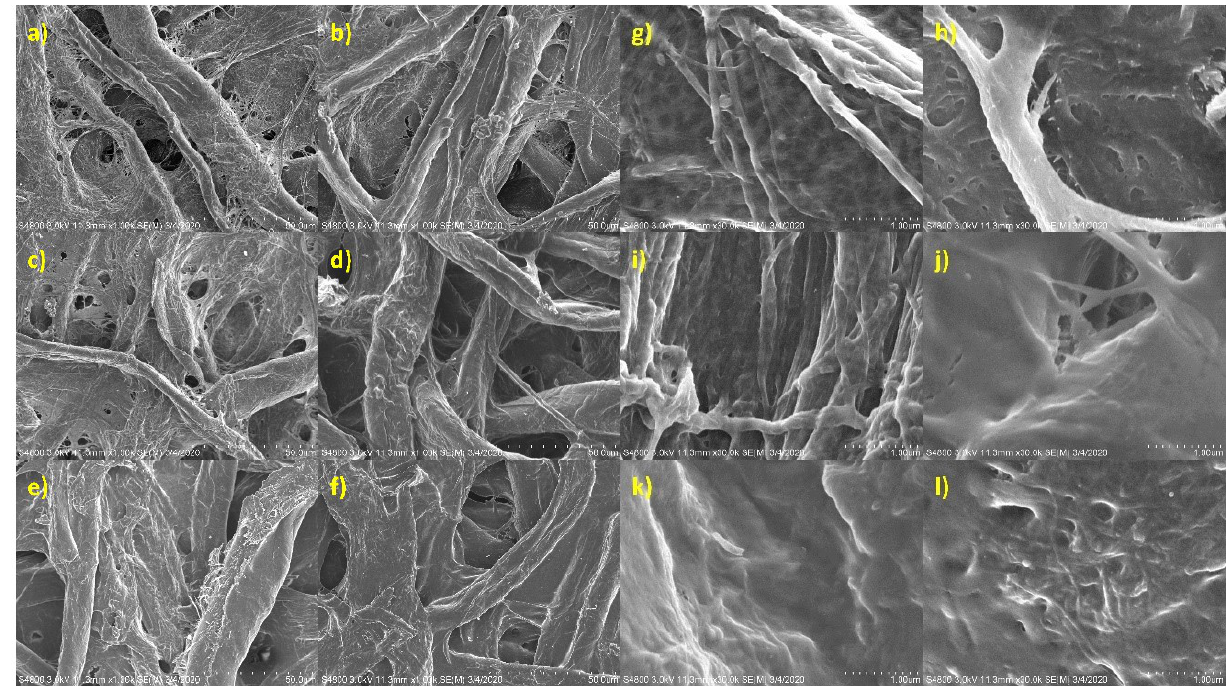
Figure 4. FESEM micrographs at 1000× ( a – f ) and 30,000× ( g – l ;) of paper ( a & g ) and paper treated with: 1 wt % CNC dispersion ( b & h ); 0.2 wt % CNF suspension ( c & i ); 10 wt % CSP solution ( d & j ); 1 wt % CNC dispersion with 10 wt % CSP ( e & k ), and; 0.2 wt % CNF dispersion with 10 wt % CSP ( f & l ).